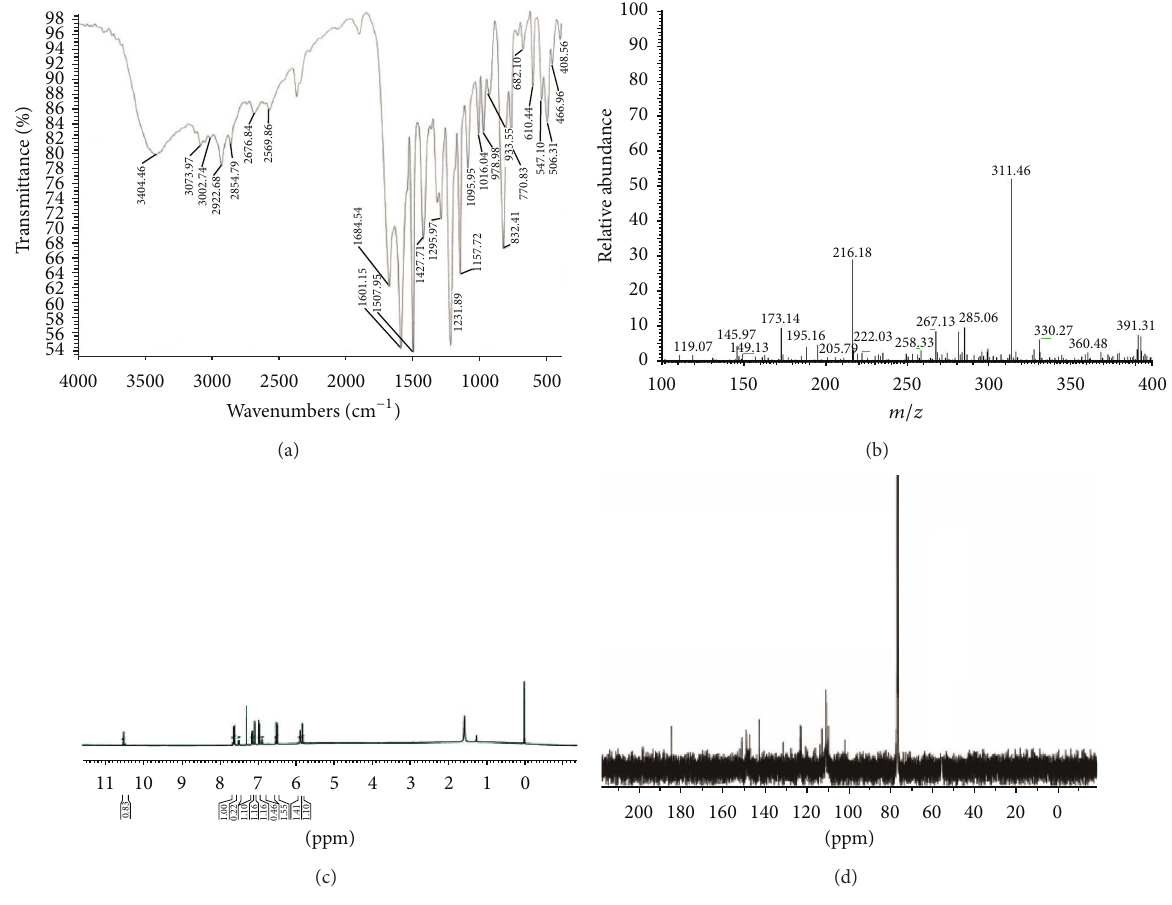
Figure 3: (a) FT-IR, (b) mass, (c) 1 H, and (d) 13 C spectra of representative compound 1 . Table 1: Physical and analytical data of curcumin analogues 1 – 5